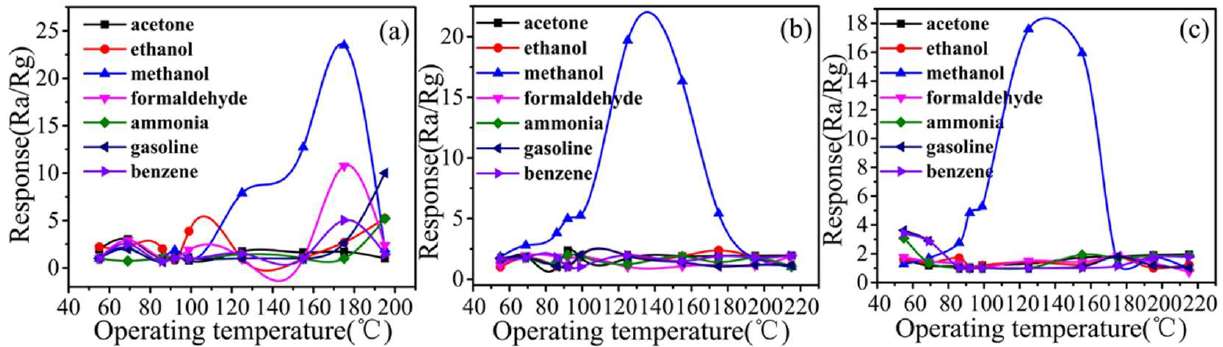
Figure 8. Methanol sensors produced by Rong et al. on exposure to different VOCs at 5 ppm. The three sensors were produced using different support fibres: paper ( a ), silk ( b ), or cotton ( c ). Methacrylic acid and an Ag-LaFeO 3 sol were reacted in methanol to give a gel used to coat the different supports. Each material was then ground and printed onto an alumina electrode, and the response calculated as the ratio of the electrical resistance in the specified gas (Rg) and in air (Ra). Reproduced with permission [22].